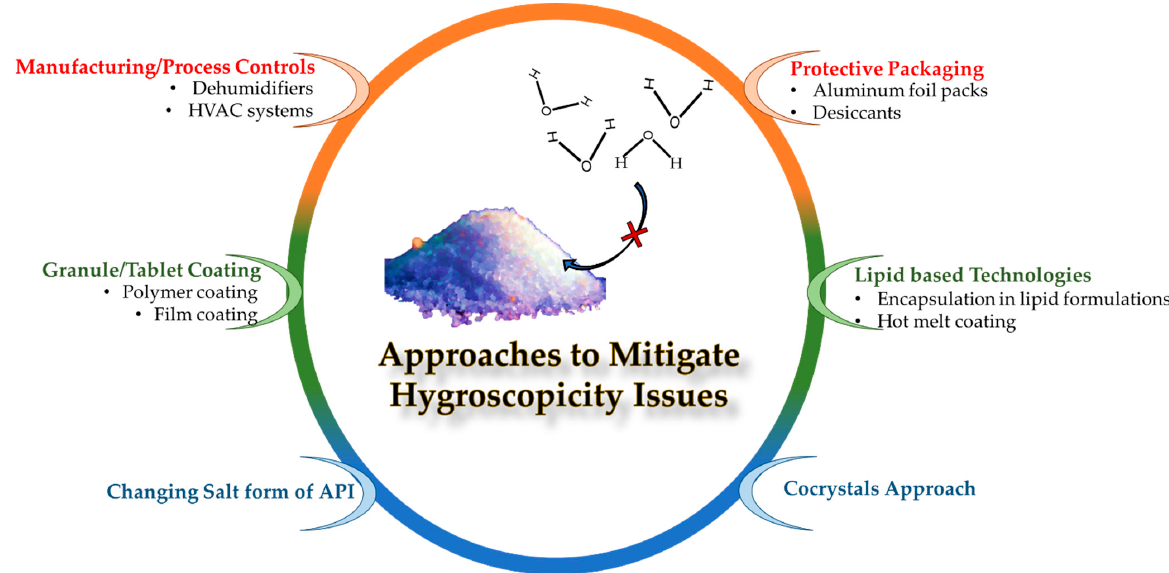
Figure 1. Illustration of methods to improve the hygroscopic stability of moisture-sensitive APIs. Generally, solid pharmaceutical dosage forms show better stability than liquid dos- age forms. Furthermore, the use of co-crystals in place of plain APIs can add significant advantages to the stability of the solid dosage form. Co-crystals have received significant attention in the last two decades as a novel solid form because of their capability to modify the pharmaceutical and biopharmaceutical properties of APIs [24–27]. The co-crystals are formed by an API and co-formers with the action of non-covalent bonds. Co-crystals pro-